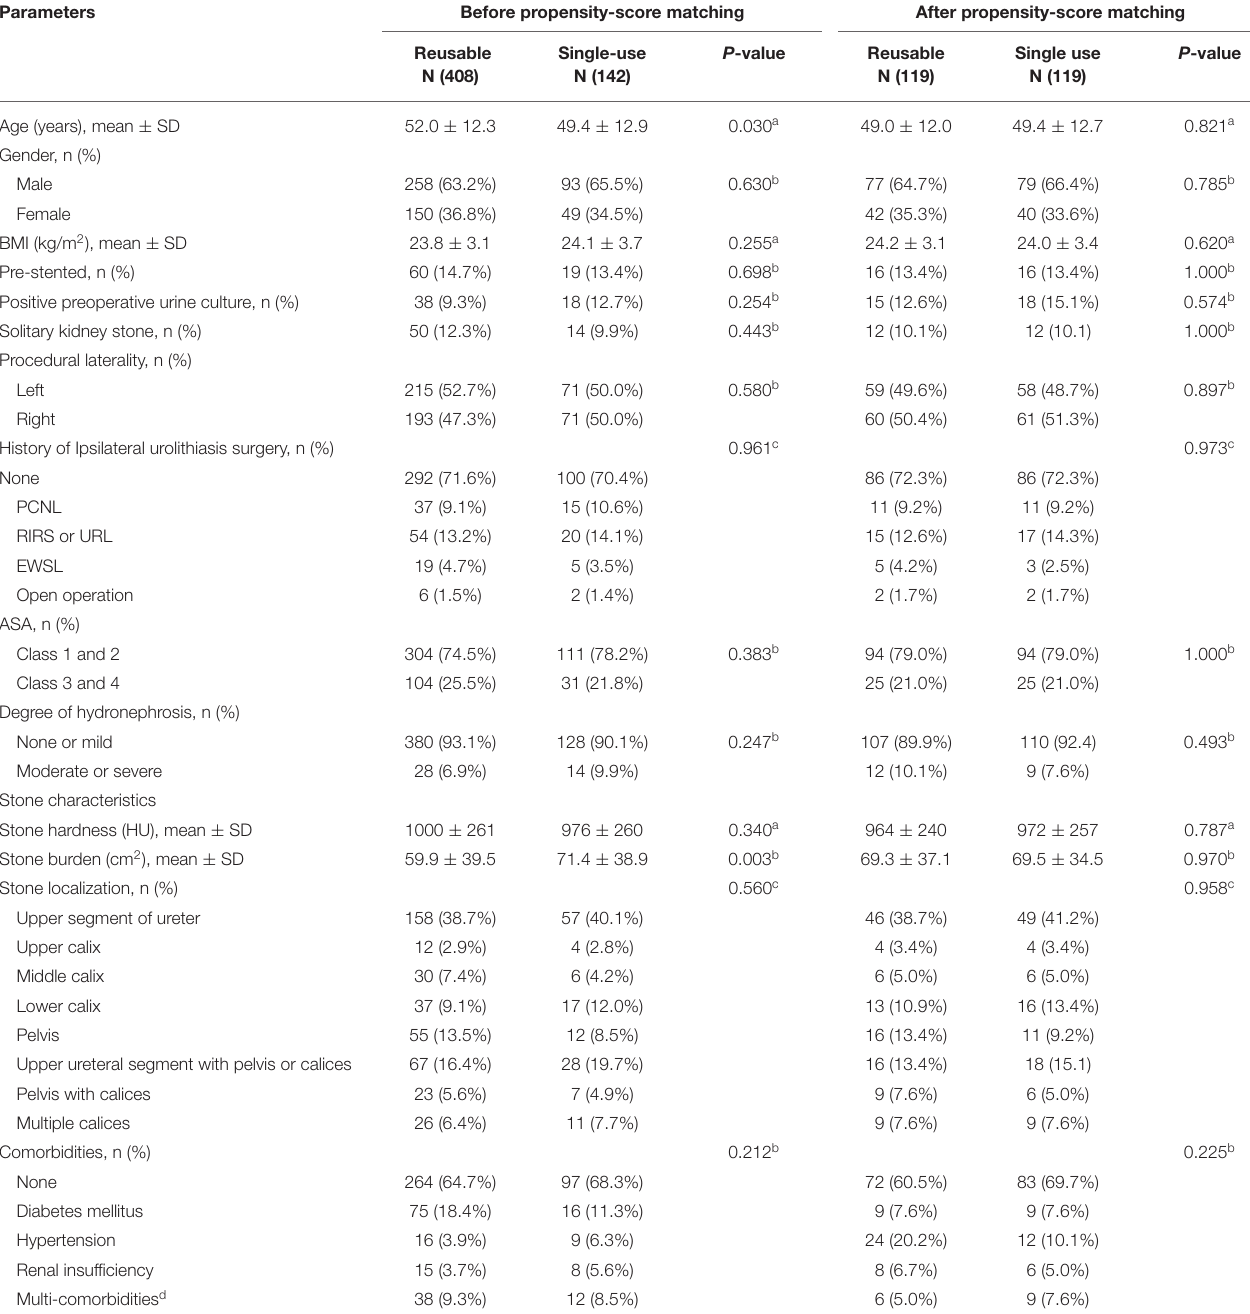
TABLE 1 | Baseline characteristics of the included patients for clinical outcomes analysis. Parameters